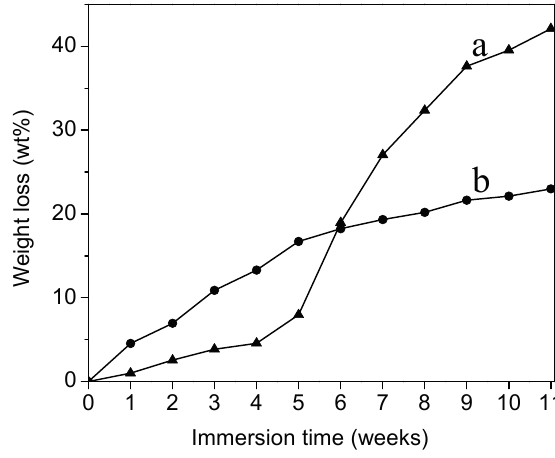
Figure 9. Weight loss of (a) PLA and (b) collagen-PLA versus degradation